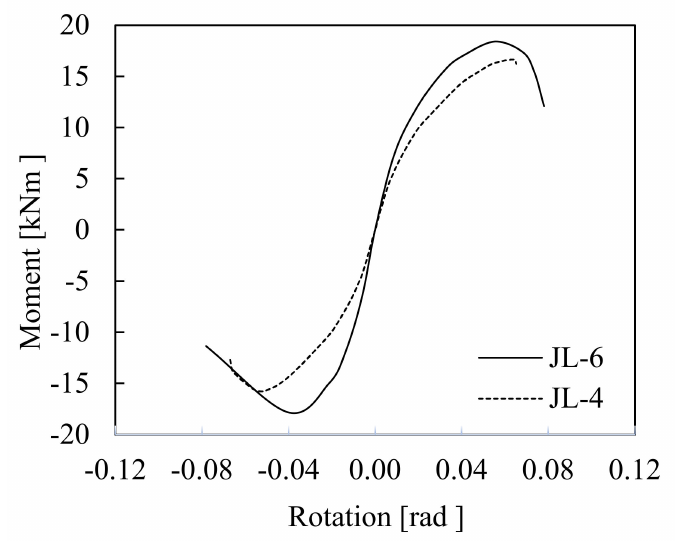
Figure 18. Skeleton curves of the steel bolted joint